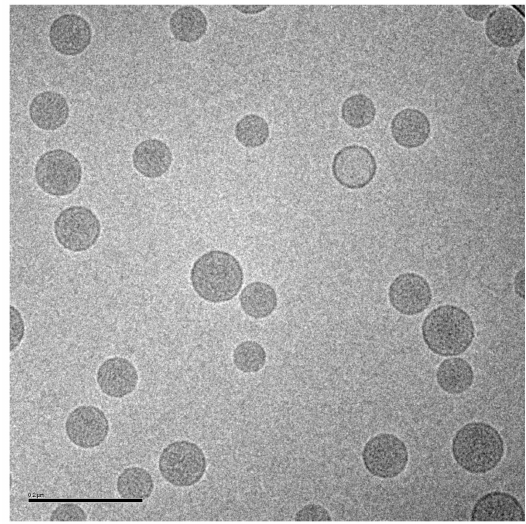
Figure 3. Cryo-TEM image of liposomal ciprofloxacin (Lipoquin). The scale bar is 200